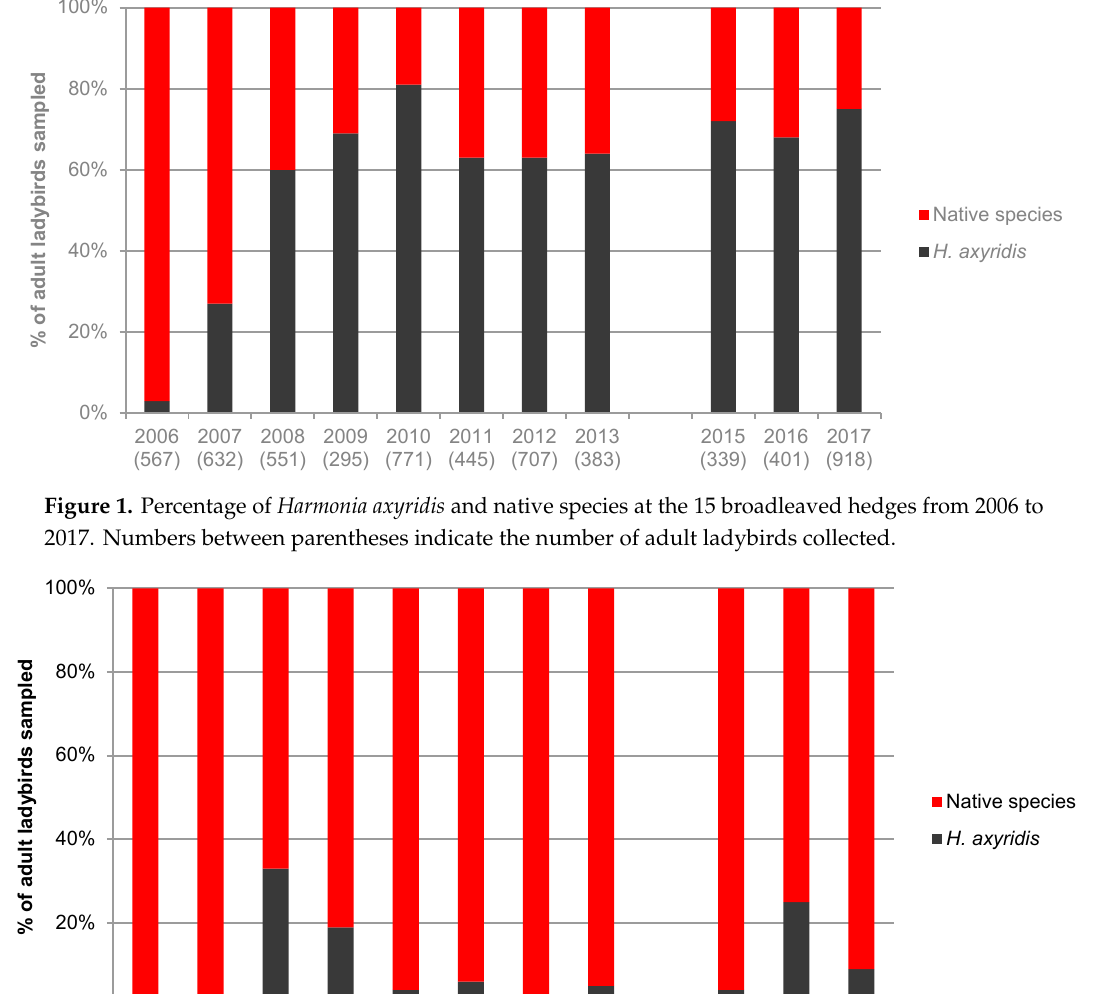
Adalia bipunctata (L.)